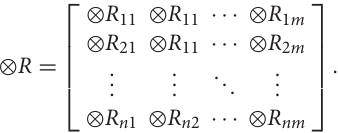
Stage 5 : Established the normalized grey decision matrix in the